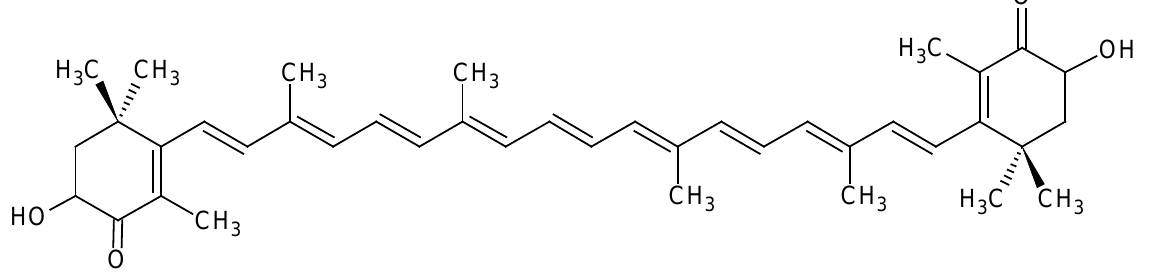
Figure 1. Chemical structure of the algal carotenoid astaxanthin